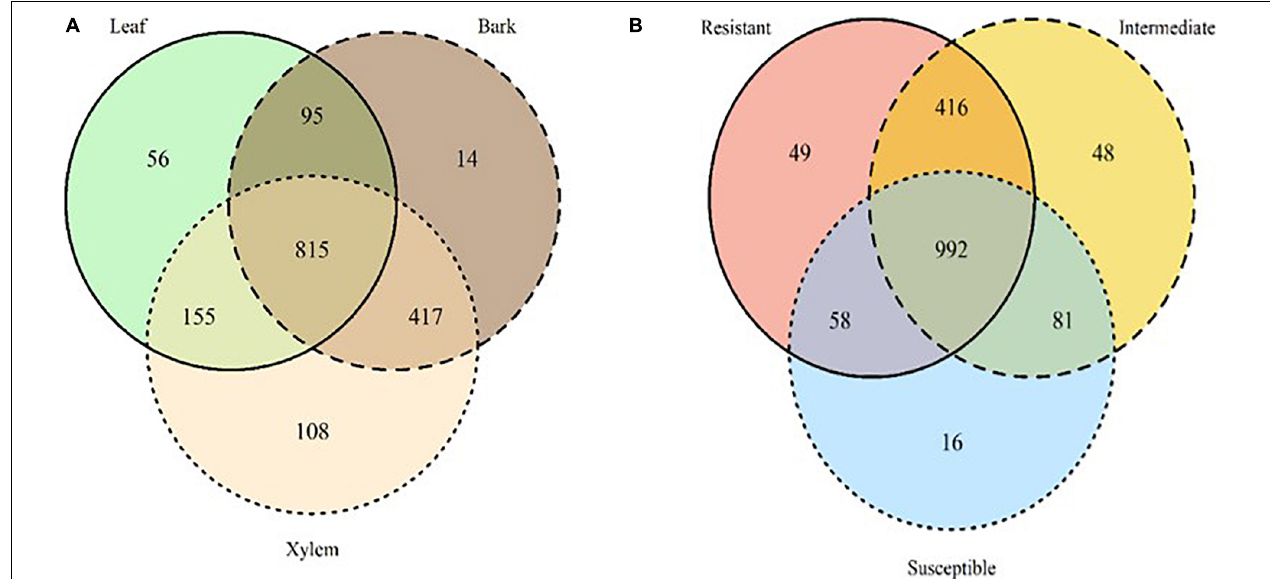
FIGURE 4 | Venn diagrams summarizing the number of OTUs detected only in ash trees by tissue type (A) leaf: solid line, green; bark: dashed line, brown; xylem: dotted line, light beige and susceptibility classes (B) resistant: solid line, red; Intermediate: dashed line, yellow; Susceptible: dotted line, blue). The overlapping areas report the number of OTUs shared among tissues and susceptibility